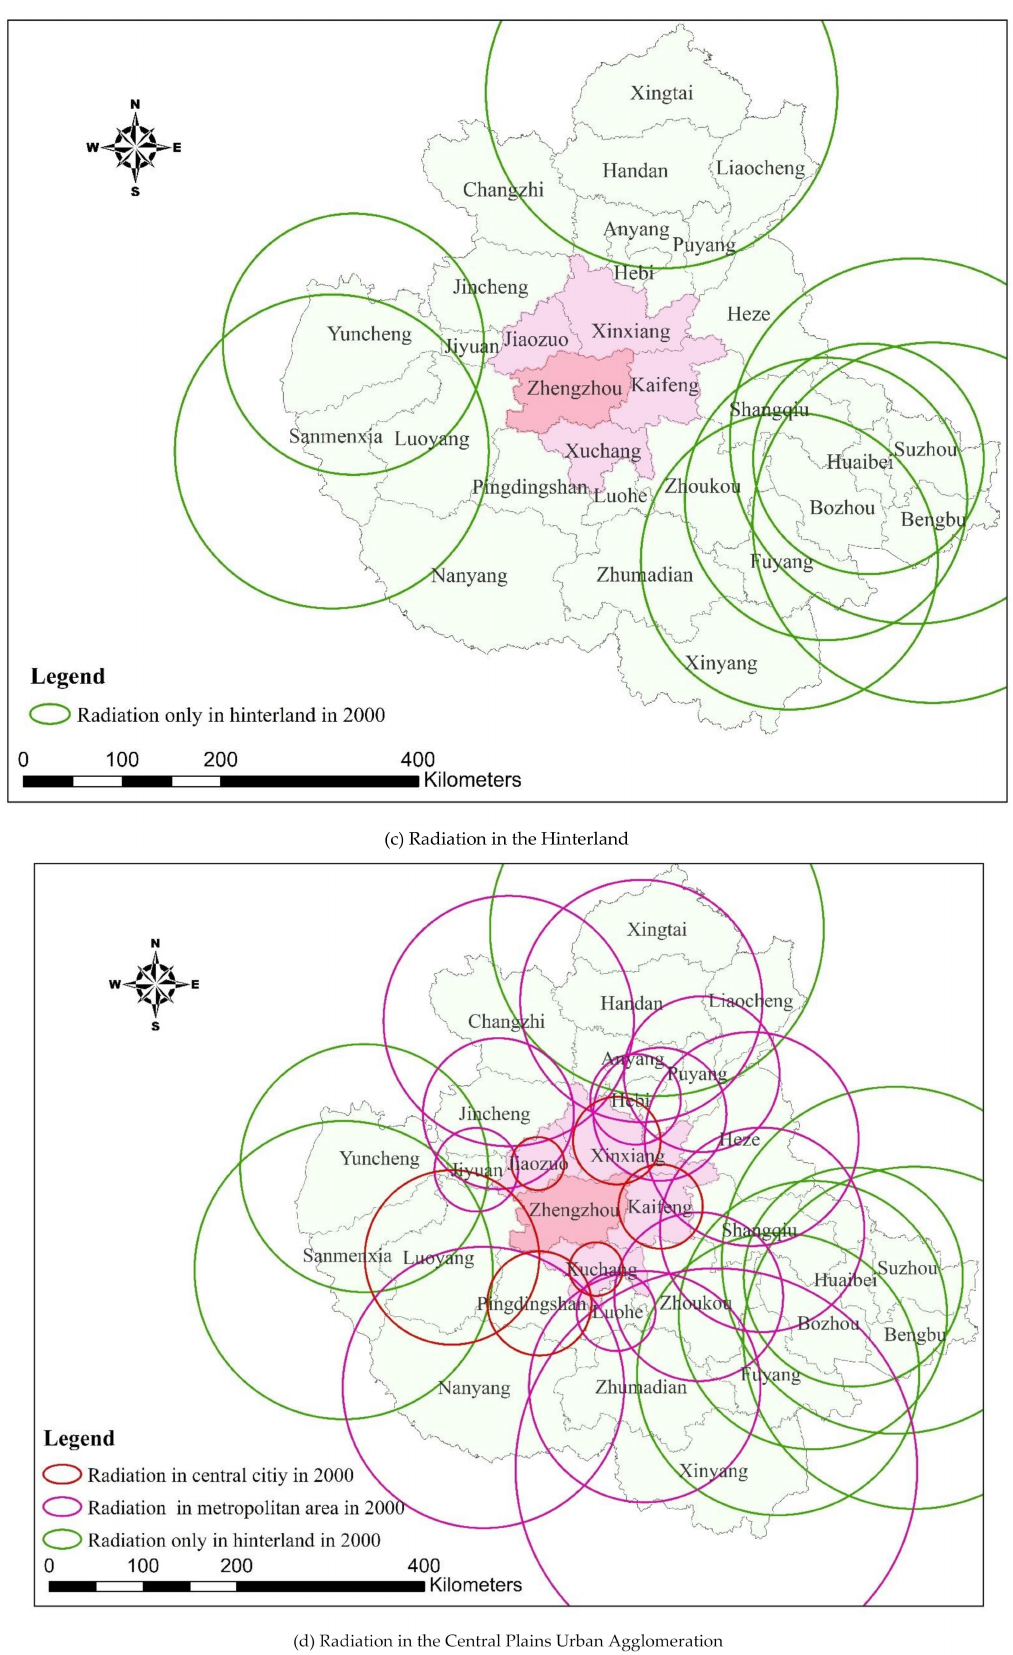
Figure 5. ESV spatial radiation range of cities in the Central Plains Urban Agglomeration in